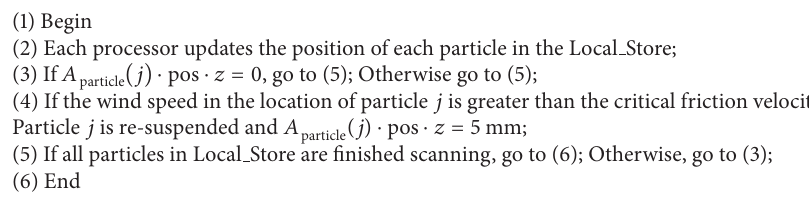
Algorithm 3: The re-suspension simulation algorithm of dust particles.